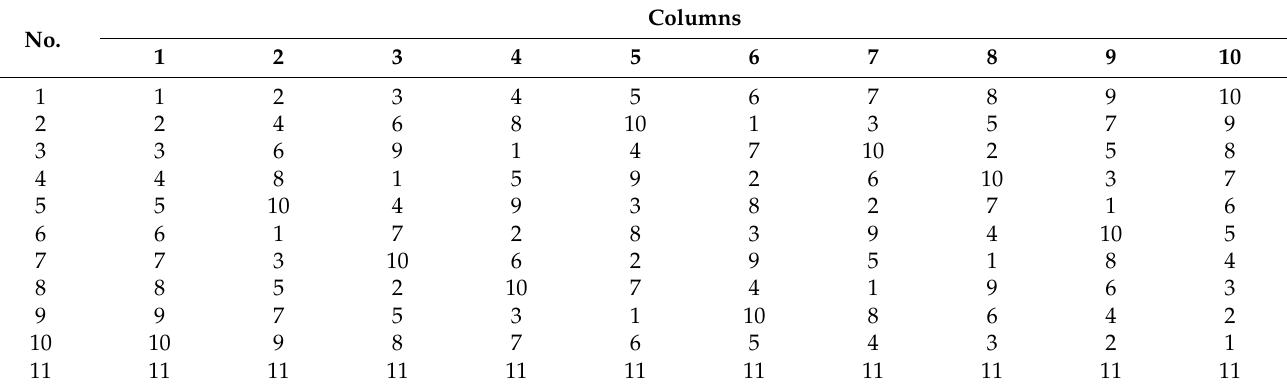
Table 1. U 11 (11 10 ) uniform layout.